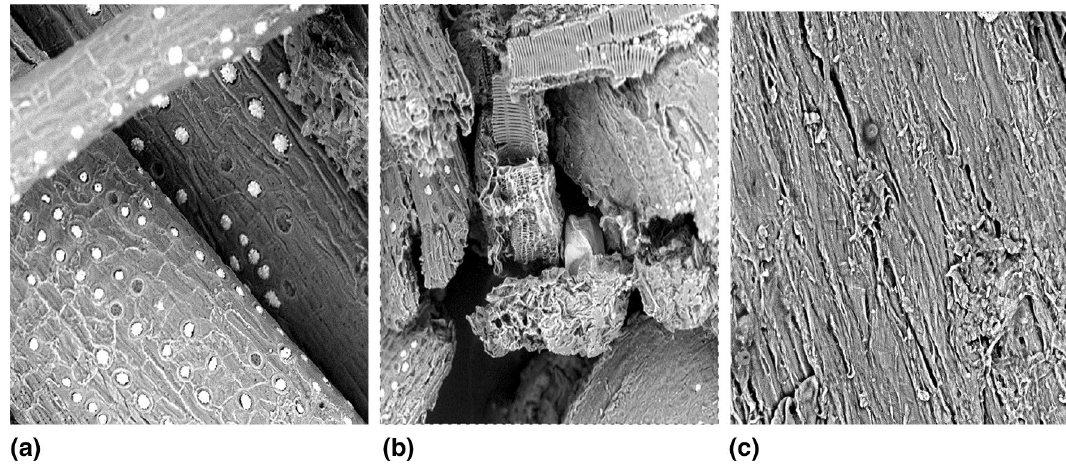
Fig. 1 SEM micrograph for unmodified ( a ), modified ( b ) and crude oil-treated ( c )